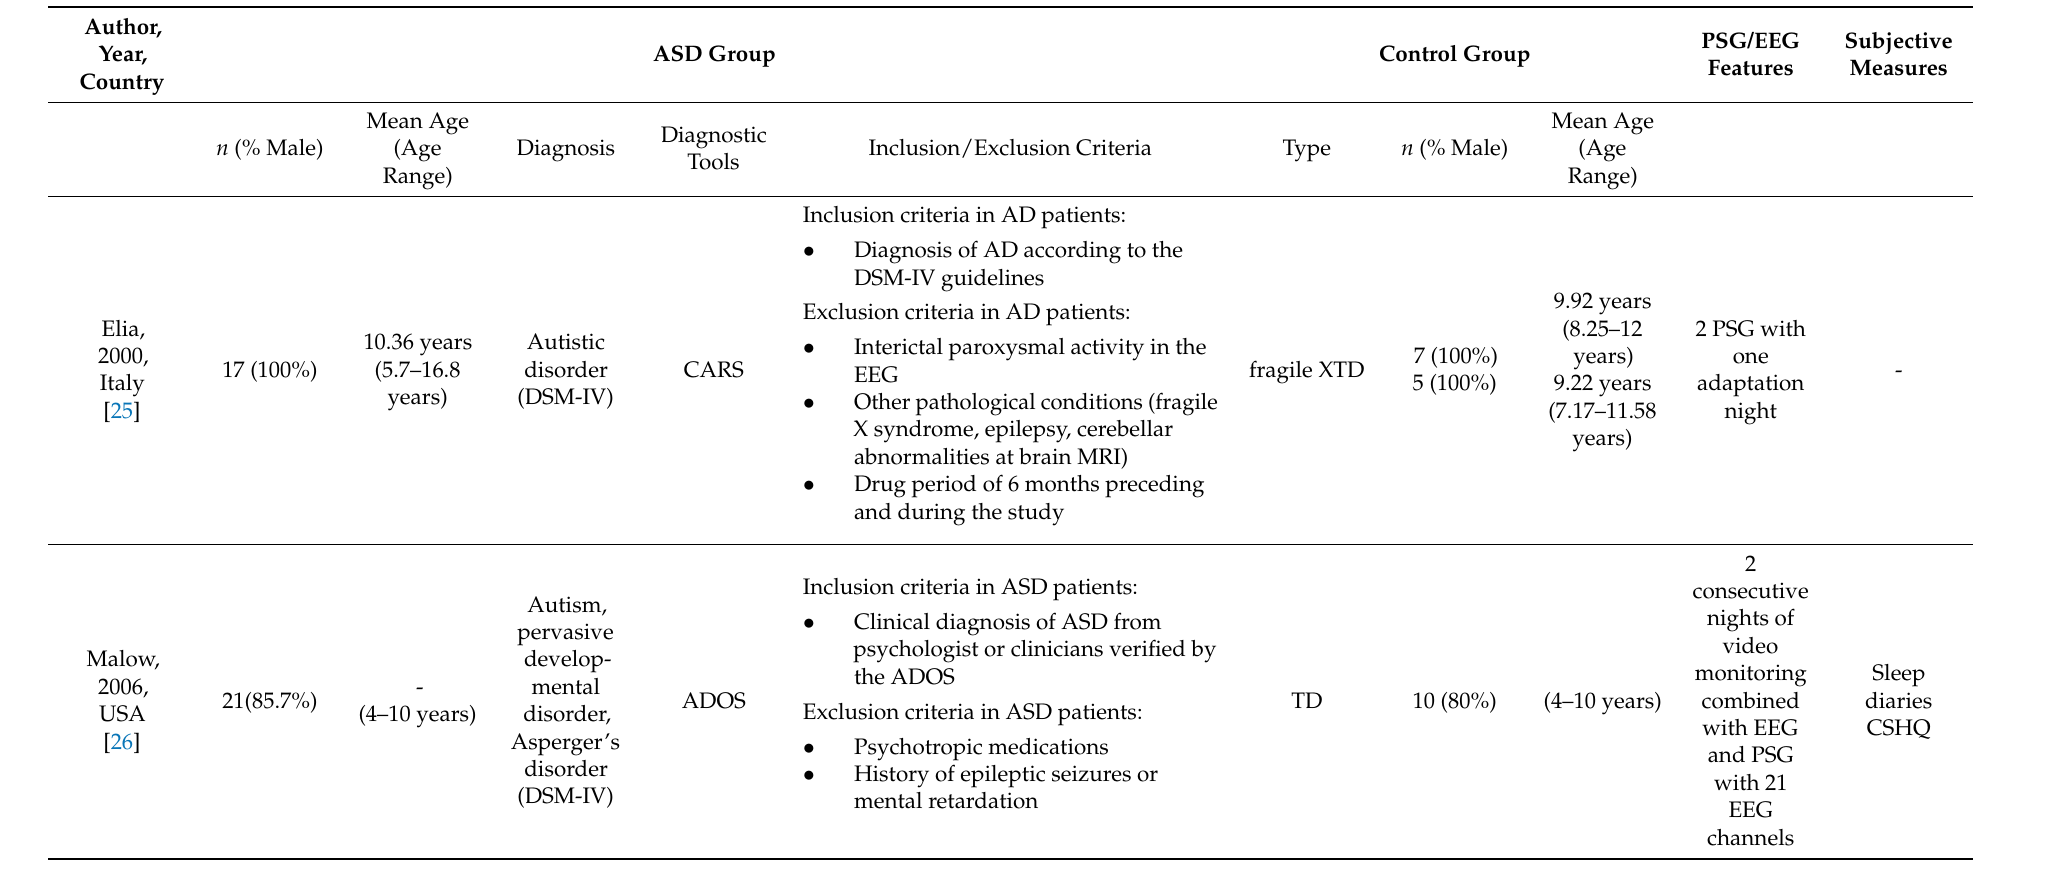
Table 1. Studies reporting findings on sleep EEG features and sleep subjective features in ASD